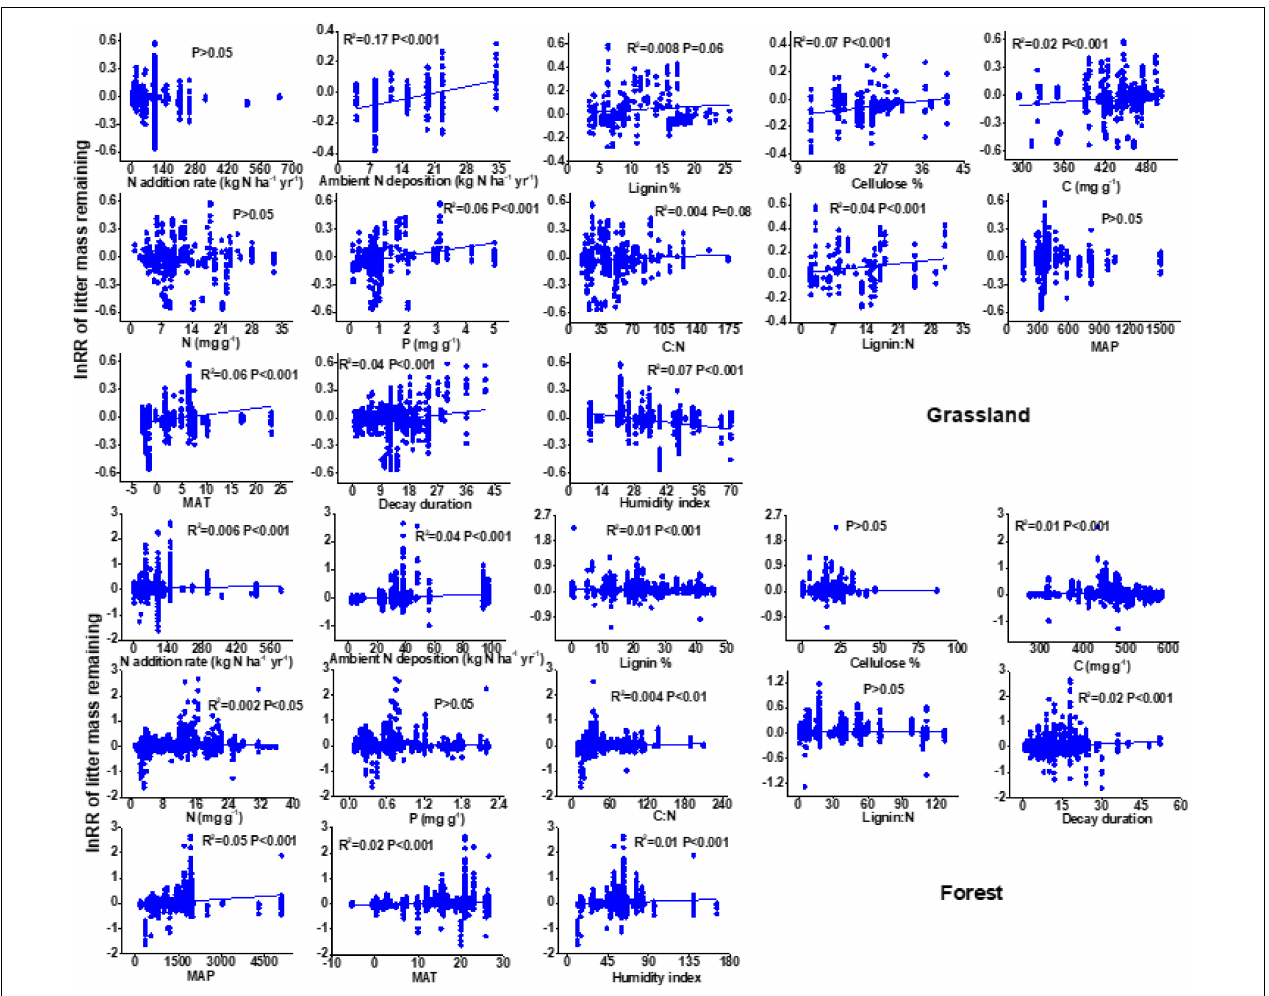
FIGURE 4 | Relationships of the response ratio of litter mass remaining after N enrichment with N enrichment rate, ambient N deposition, lignin, cellulose, litter nutrient status, and climatic factors.